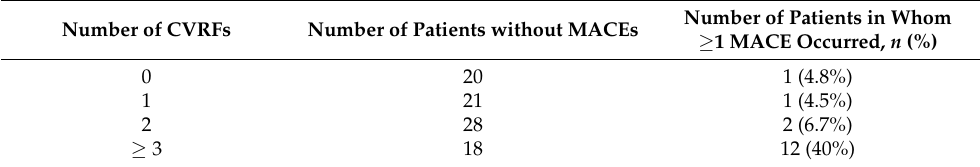
Table 2. Occurrence of MACEs according to the number of CVRFs present in patients from the OSTEOVAS cohort.